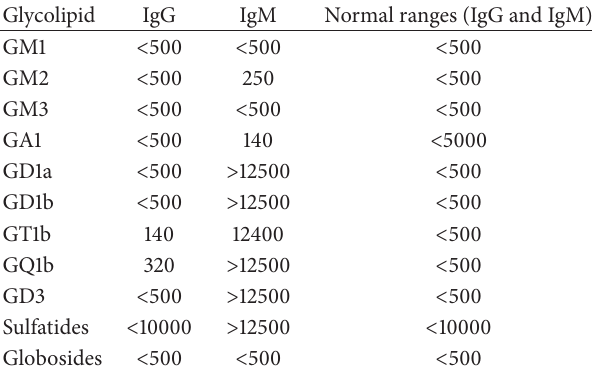
Table 2: Serum antiglycolipid Antibody titres. Provided by